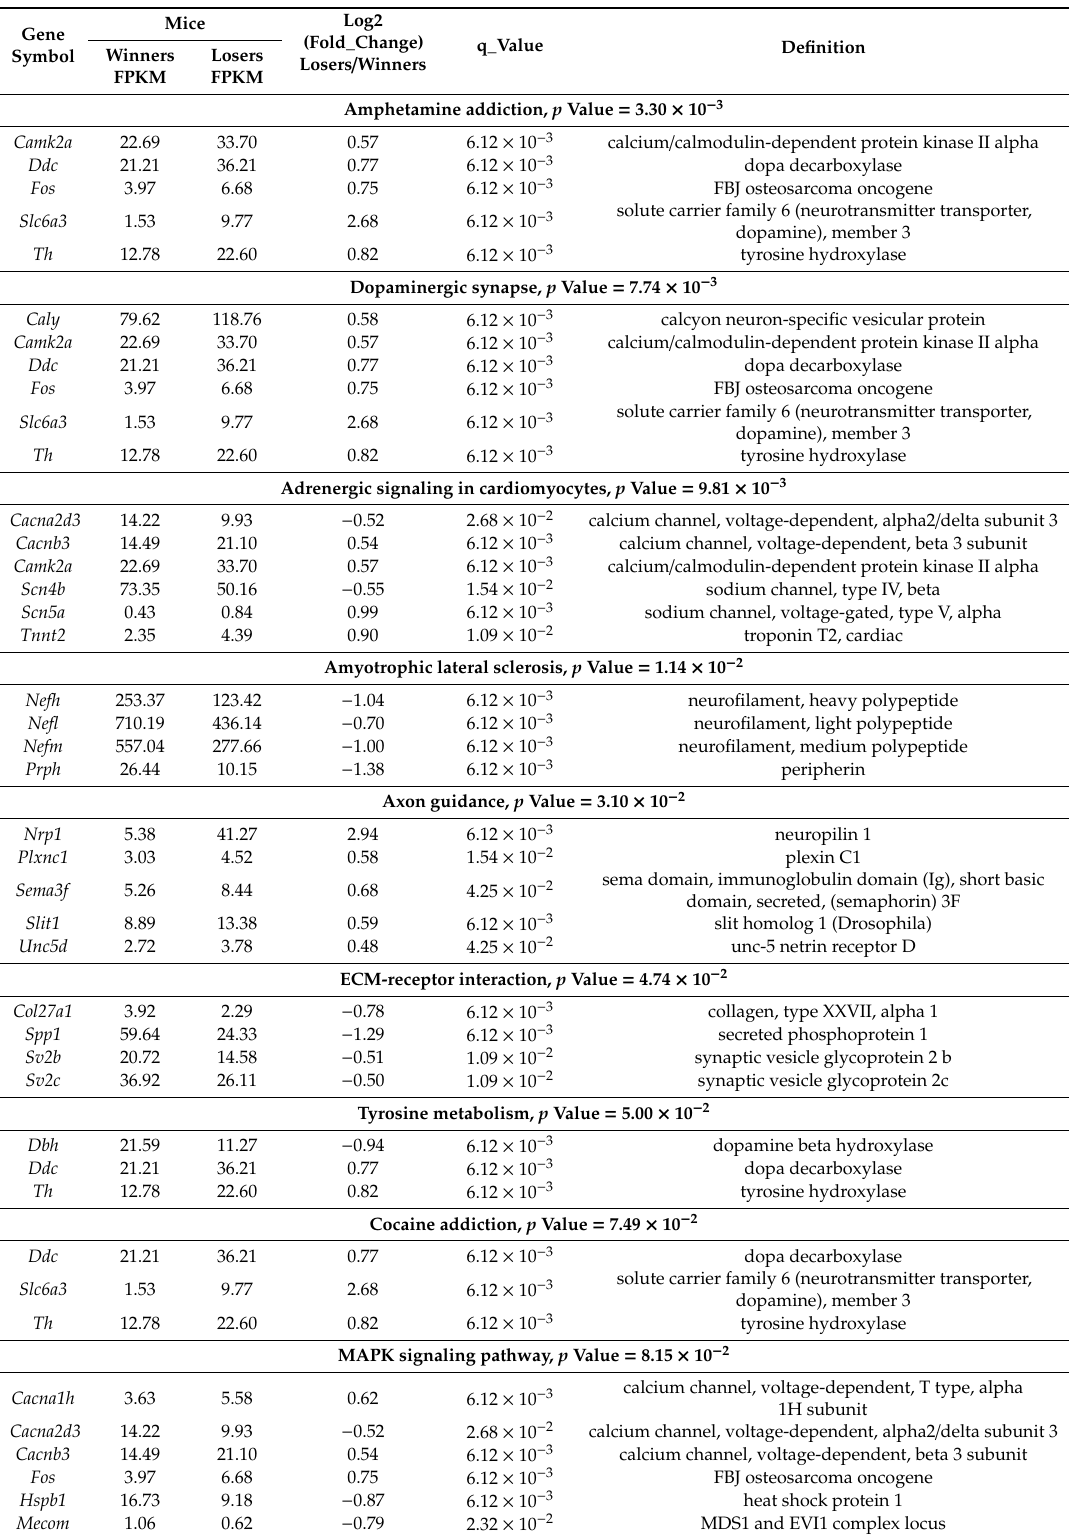
Table 5. Metabolic pathways most significantly altered in winners compared to defeated